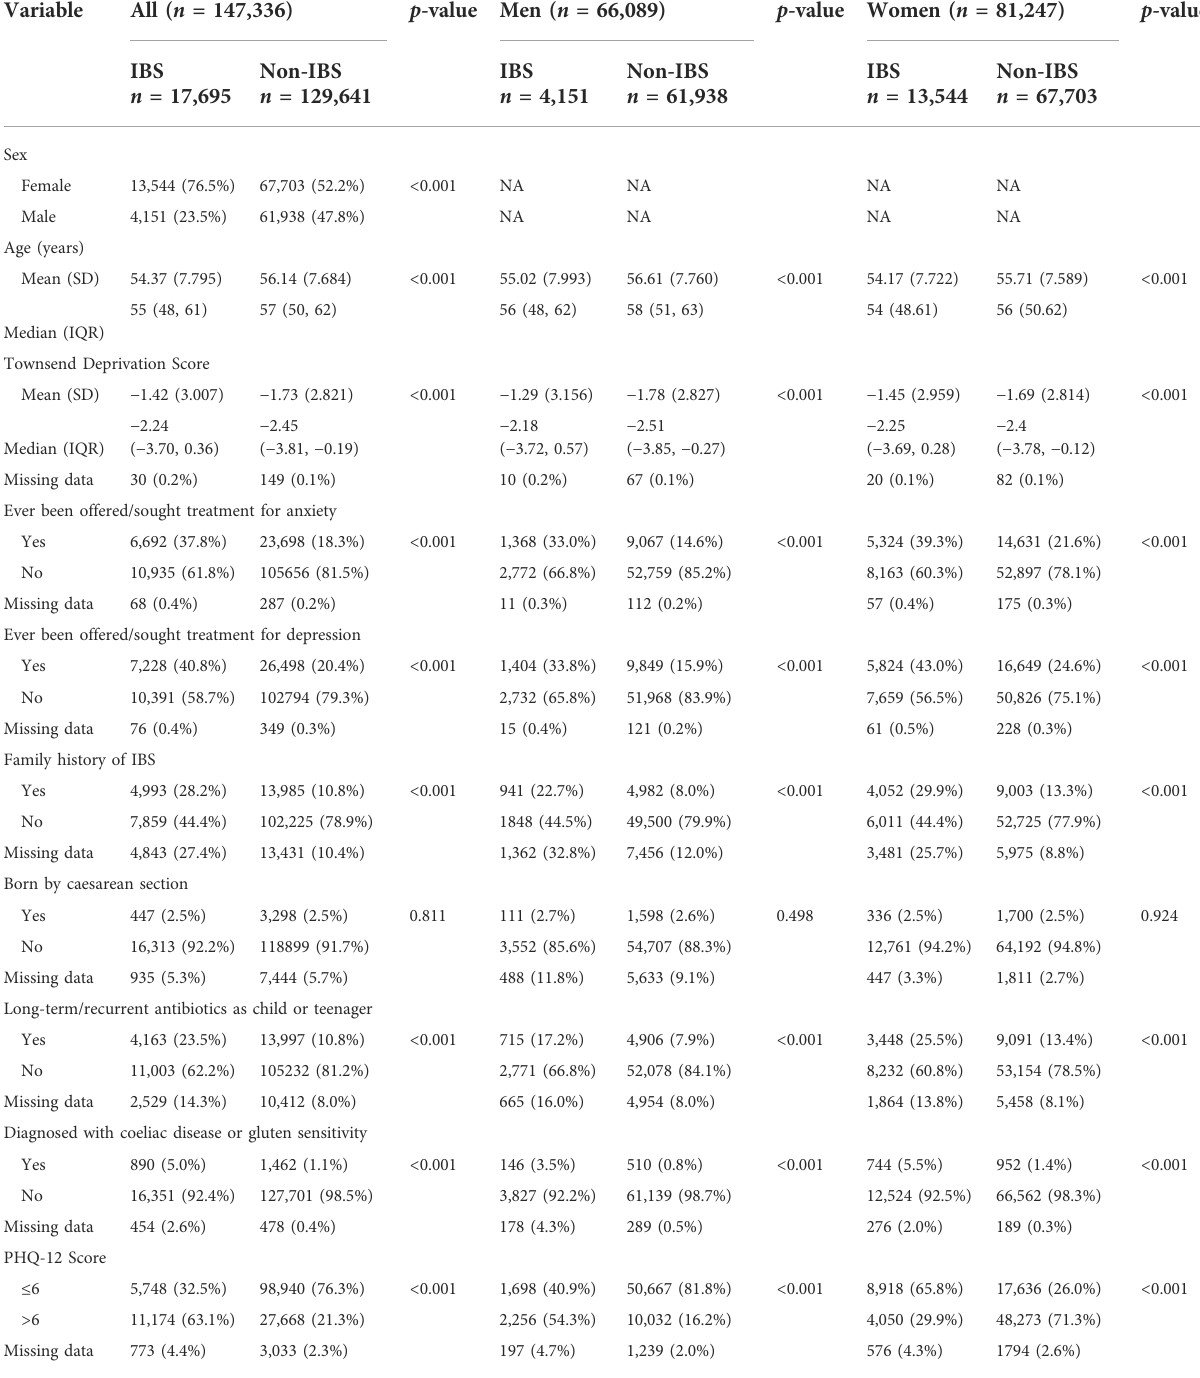
TABLE 1 Participants ’